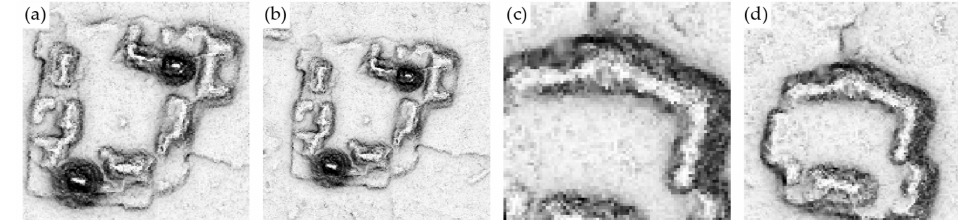
Figure 15. Comparison of generated image samples for a platform and a building. The left two plates ( a ) and ( b ) show image samples generated for the same platform; one with ( a ) a 2-pixels edge bu ff er, and the second with ( b ) a 15-pixels edge bu ff er added to the structure’s bounding box. The two plates on the right ( c ) and ( d ) show building samples with ( c ) a 2-pixels edge bu ff er and with ( d ) a 15-pixels edge bu ff er added to the bounding box of a building. Scale